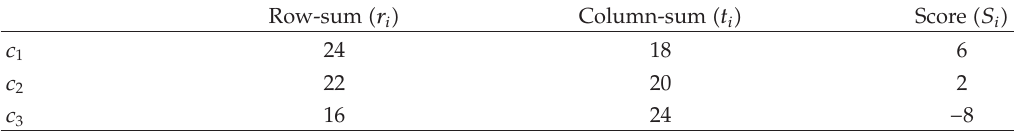
Table 7: Tabular representation: U (cid:5) H,D (cid:6) . 3 -fuzzy soft multiset part of 2 U d d d d d d d d 3 1 , 1 1 , 2 1 , 3 1 , 4 1 , 5 1 , 6 1 , 7 1 , 8 v 1 0 0 0.5 0.5 0 0.8 0.5 0 v 2 0 0 0.5 0.3 0 0.8 0.6 0 v 3 0 0 0.7 0.4 0 1 0.8 0